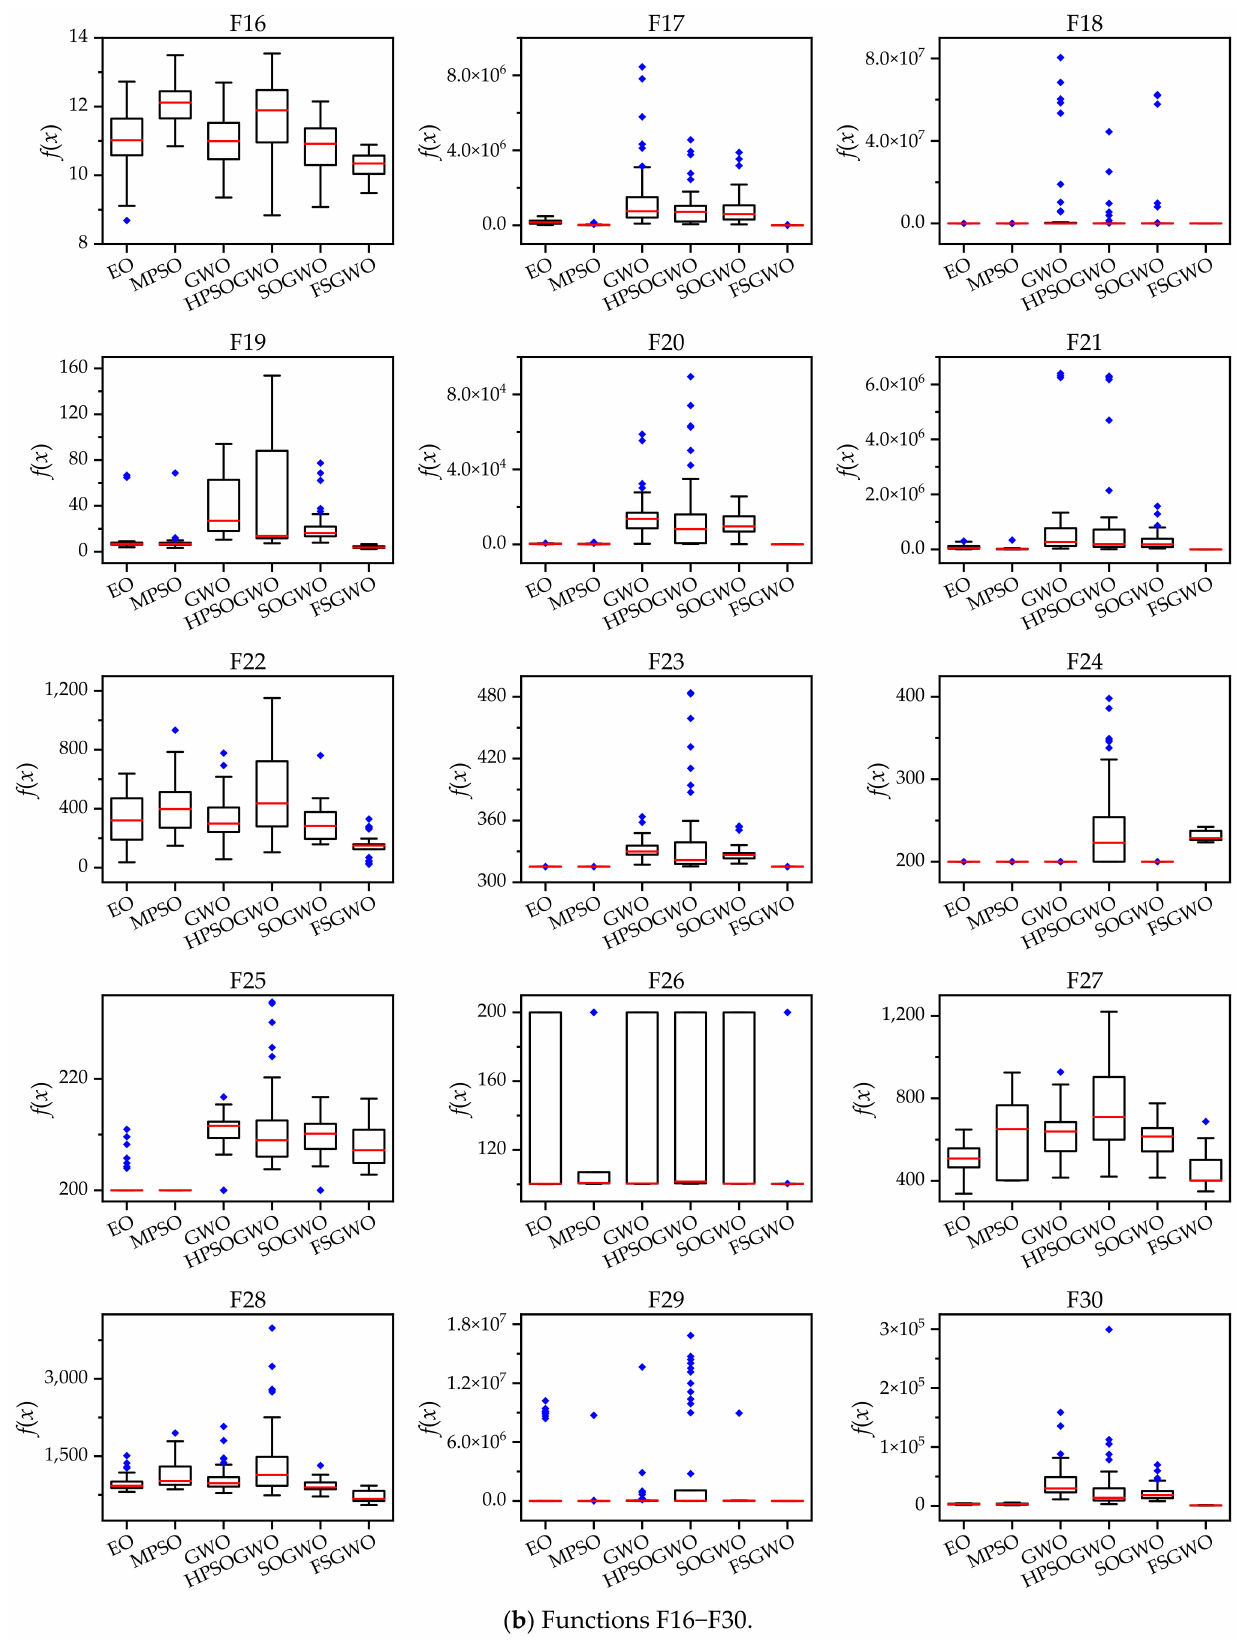
Figure 2. The box plots of the related algorithms for the 30-dimensional